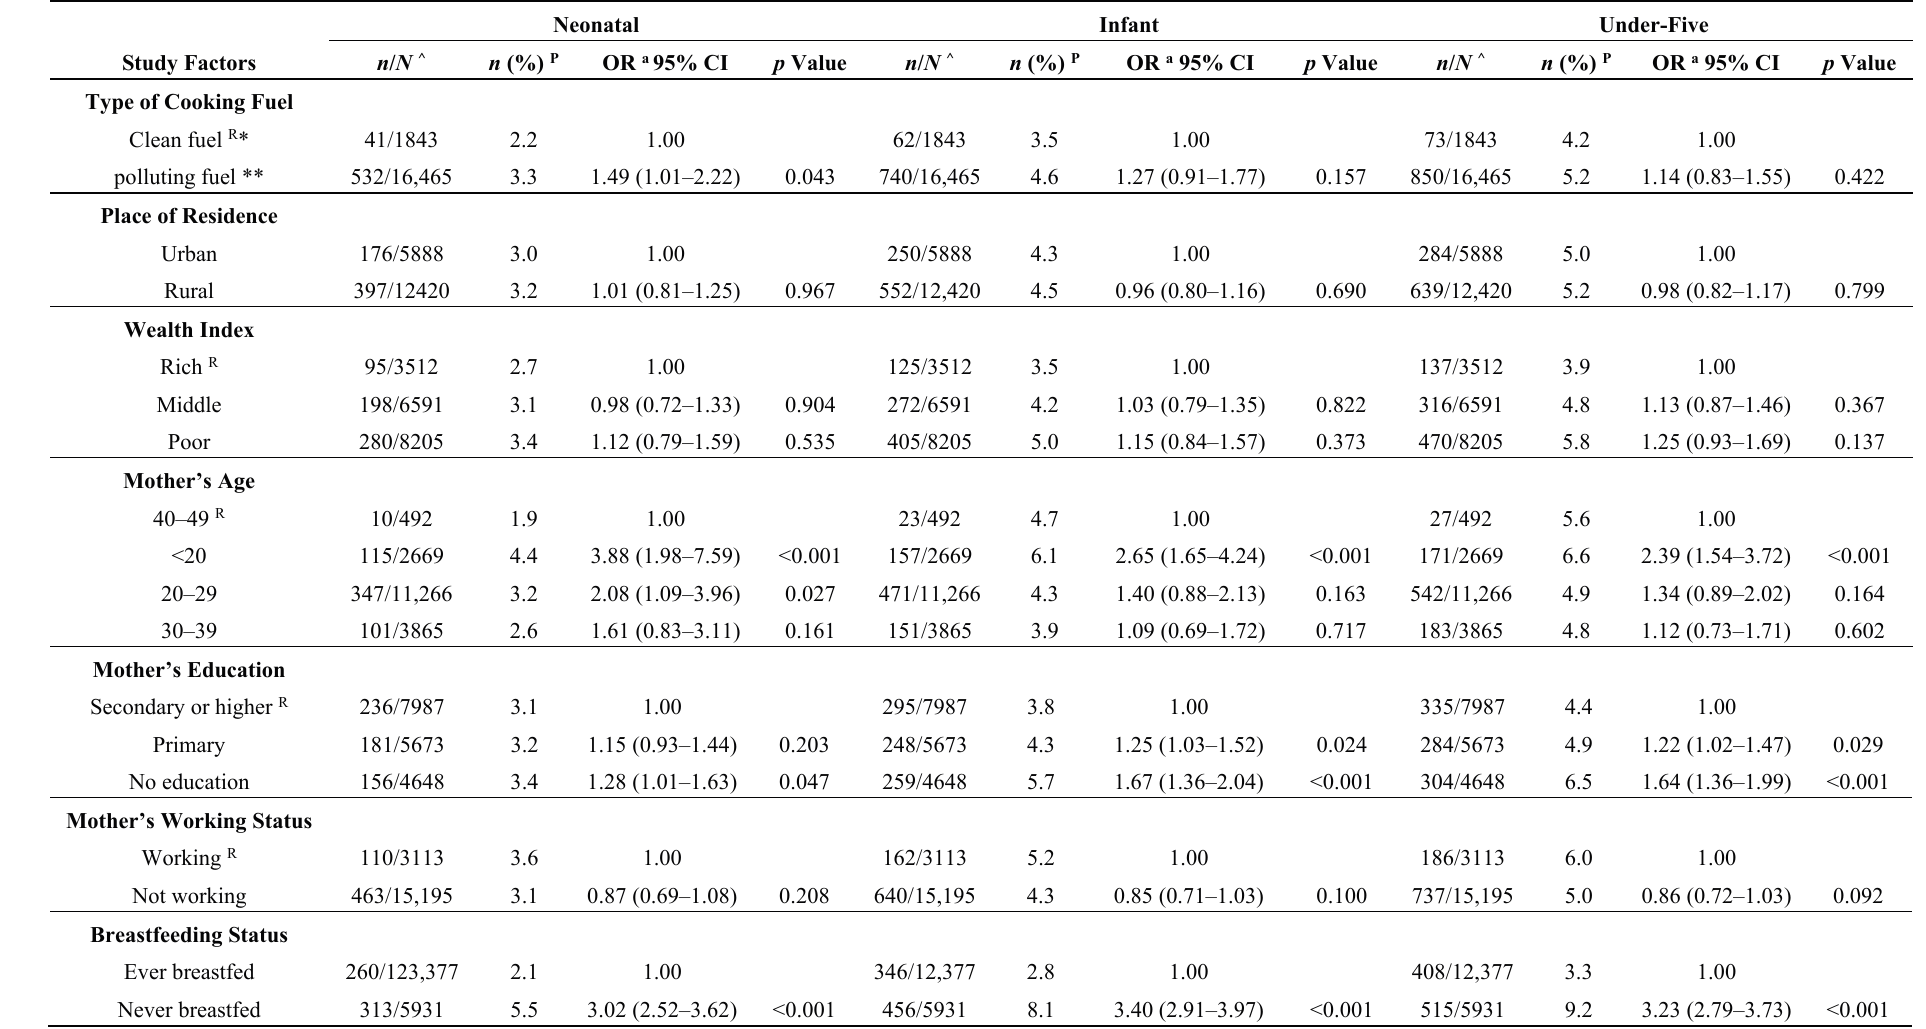
Table 1. HAP from cooking fuels associated with neonatal, infant and under-five mortality in Bangladesh: a pooled analysis for 2004–2011. Neonatal Infant